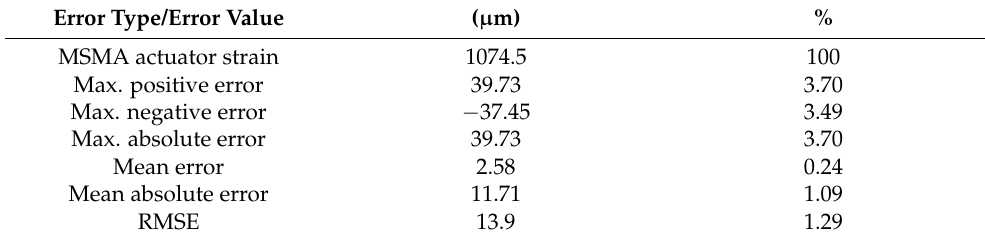
Table 3. Analysis of GPI errors.